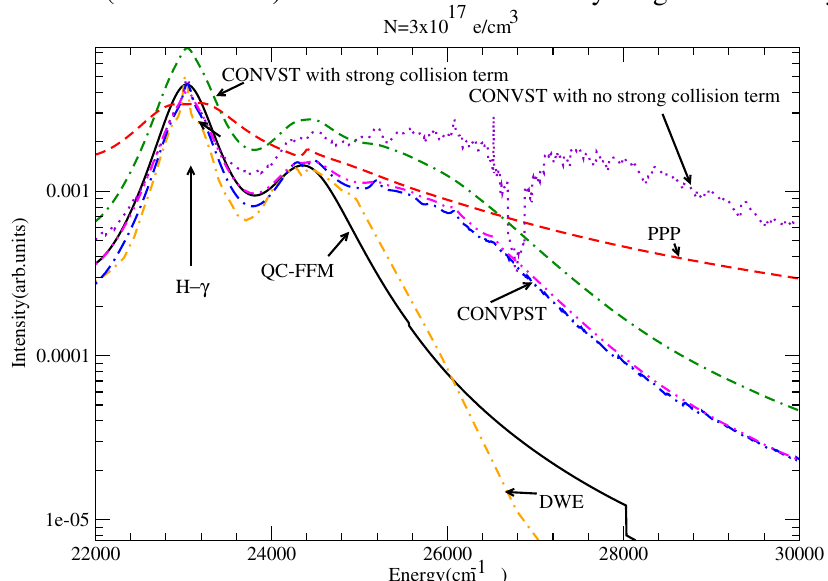
Figure 9. The series from H γ to the continuum at the lowest density showing fairly small overlap. Shown are QC-FFM (solid), PPP (dashed), DWE (dash-dotted), CONVST without strong collisions (dotted), CONVST with strong collisions (dot-double dashed), CONVPST without strong collisions (long dash-dotted) and CONVPST with strong collisions (dash-double